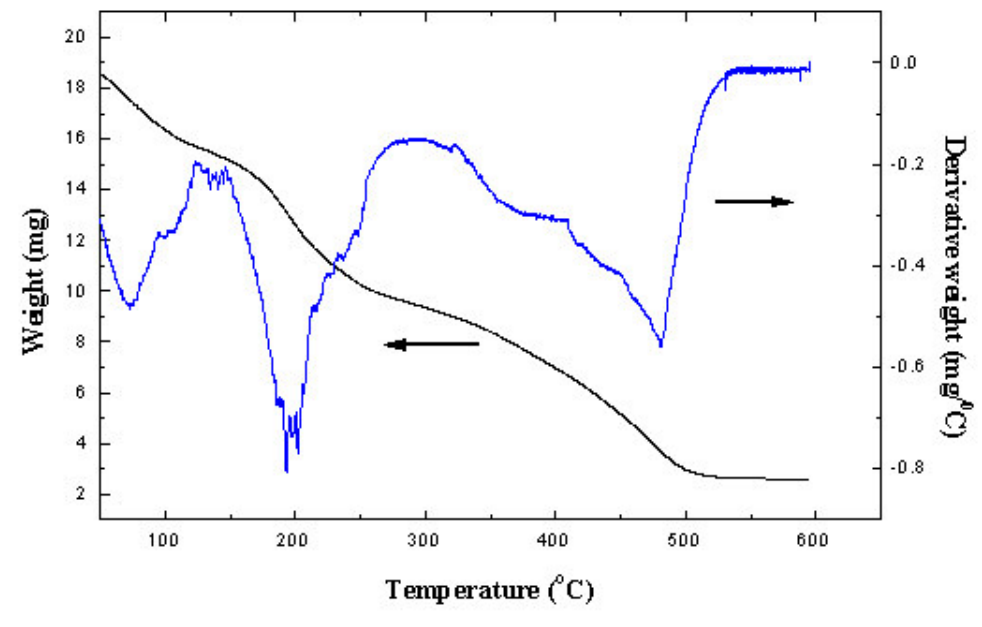
Figure 1. Thermal analysis result of evaporated sol-gel